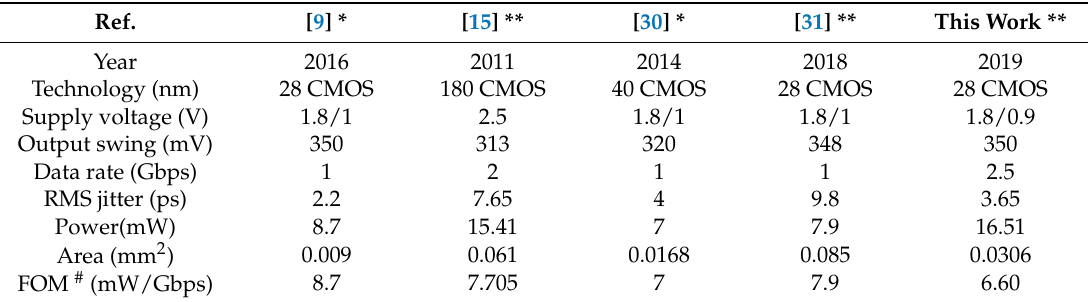
Table 1. Comparison with previous works.